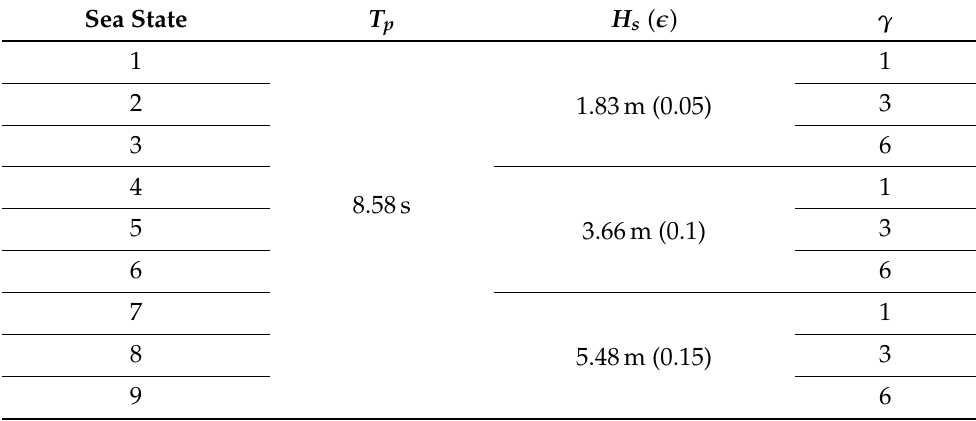
Table 2. Overview of the experimentally investigated characteristic sea state parameters.